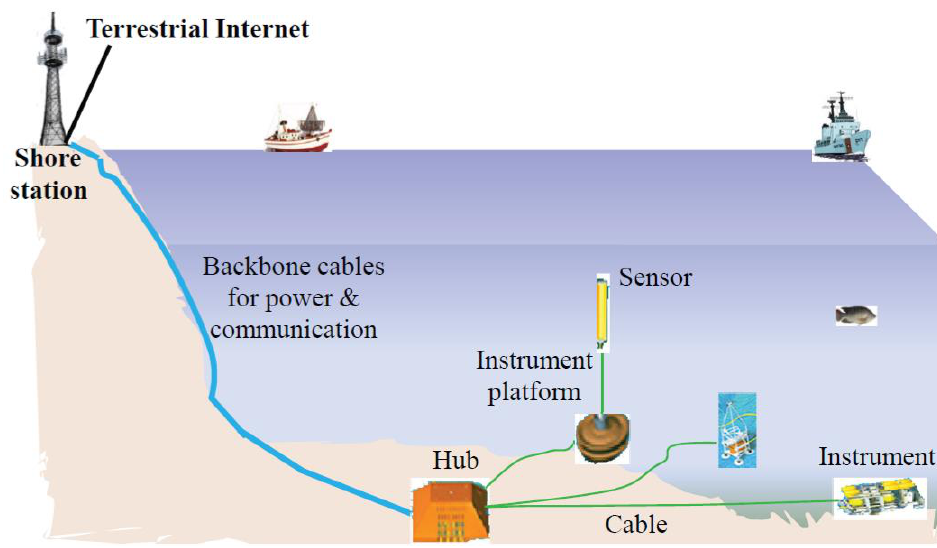
Figure 7. Overview of the MARS architecture [48].